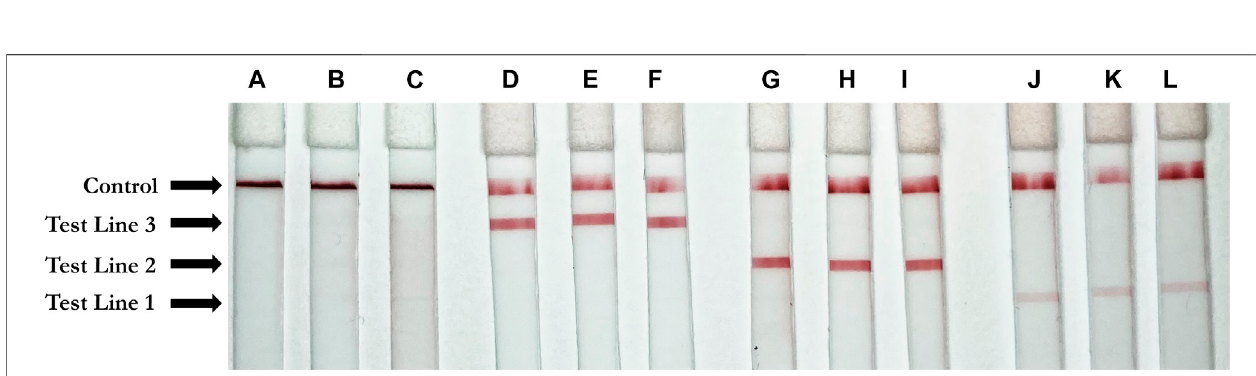
FIGURE4| Positivetestresultsforthreeuniquegeneblocks(subsectionsofSARS-CoV-2viralgenome).TestLine1(TexasRedAntibody,1 mg/ml,Cat.#A-6399, ThermoFisher Scienti fi c, Waltham, MA, United States); Test line 2 (Fluorescein antibody, 1 mg/ml, Cat. #ab19491, Abcam, Cambridge, United Kingdom); Test Line 3 (Digoxigeninantibody,2.5 mg/ml,Cat.#3210-0488,Bio-Rad,Hercules,CA,UnitedStates);Controlline(biotinylatedbovineserumalbumin,3 mg/ml,Cat.#B-2007-10, Vector Labs, Burlingame, CA, United States) (A – C) Negative control. (D – F) Orf1a gene block (1 ng/ μ l) (G – I) N gene block (1 ng/ μ l) (J – L) E gene block (1 ng/ μ l).